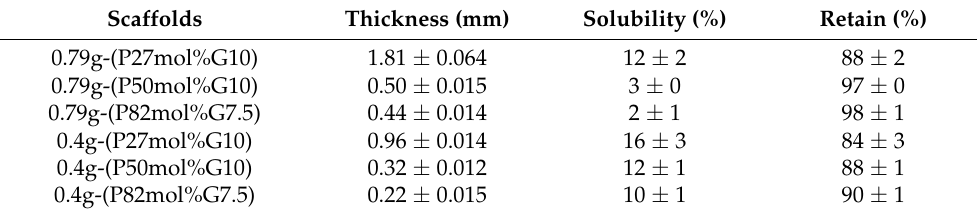
Table 3. The thickness and solubility of P(3HB- co -4HB)/gelatine blend scaffolds.